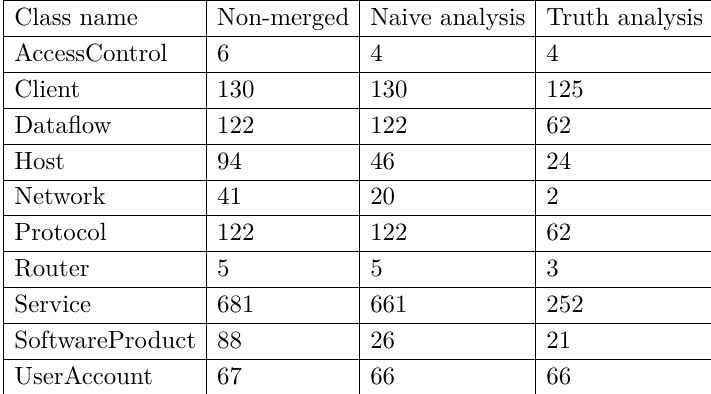
Table 8. Number of different model objects created using naive and truth analysis in the securiCAD modeling